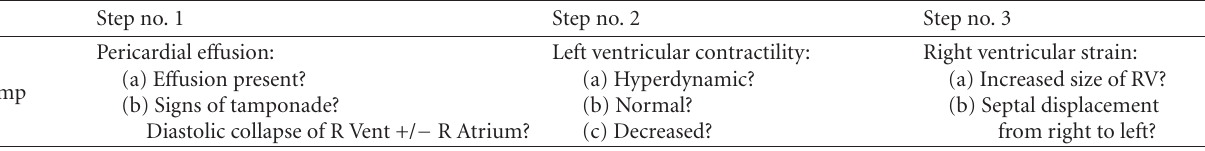
Table 2: Using the RUSH protocol to diagnose the type of